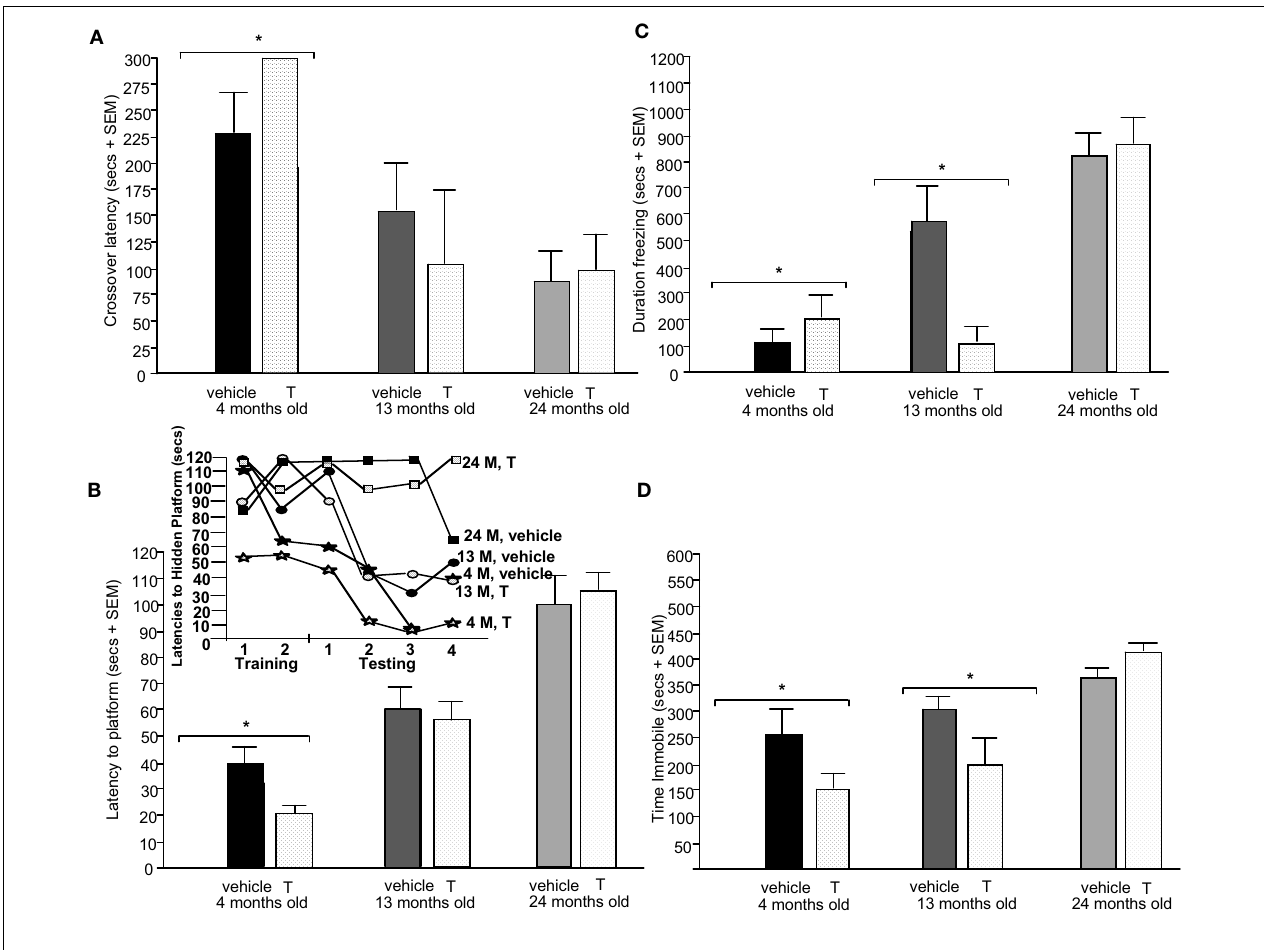
inhibitory avoidance task (A), water maze (B), defensive freezing task (C), and forced swim task (D). * over brackets denotes difference at that age group compared to age groups that do not have a bracket above bars ( p <